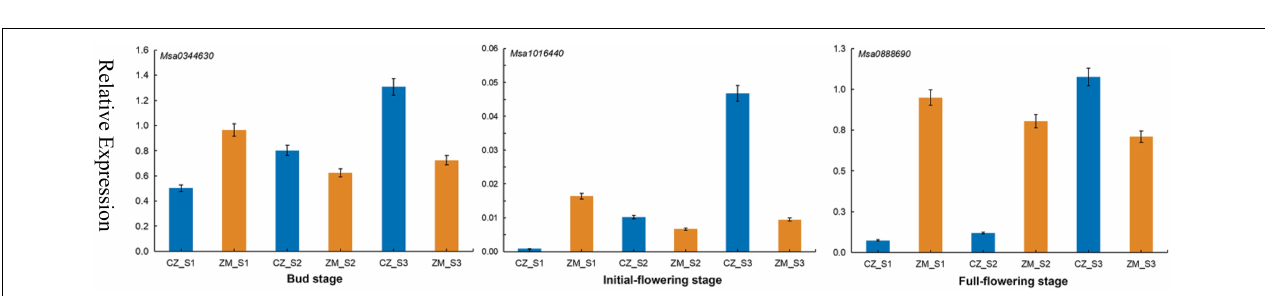
FIGURE 5 | Transcriptomic analysis. (A) Number of upregulated genes (orange) and downregulated genes (blue) during alfalfa flowering at three different periods. (B) Upregulated and downregulated DEGs in the three periods. (C) Heatmap clustering of all DEGs according to their expression level. The different colors indicate different levels of expression. The blue box above represents the early flowering varieties, and red represents the late-flowering varieties.